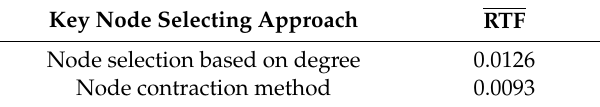
Table 3. RTF (residual threat factor) of two key node selecting approaches in two scenarios.